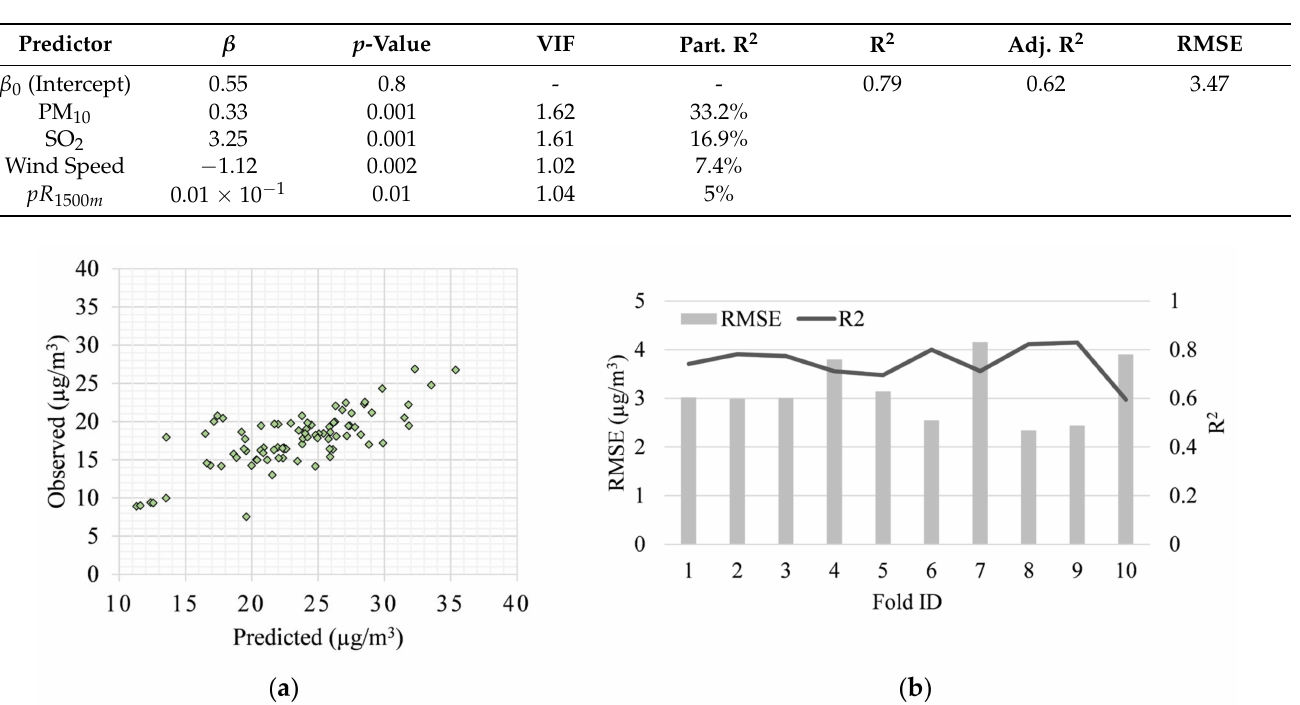
Table 6. Predictor coefficients in Model B for PM 2.5 concentration estimation.